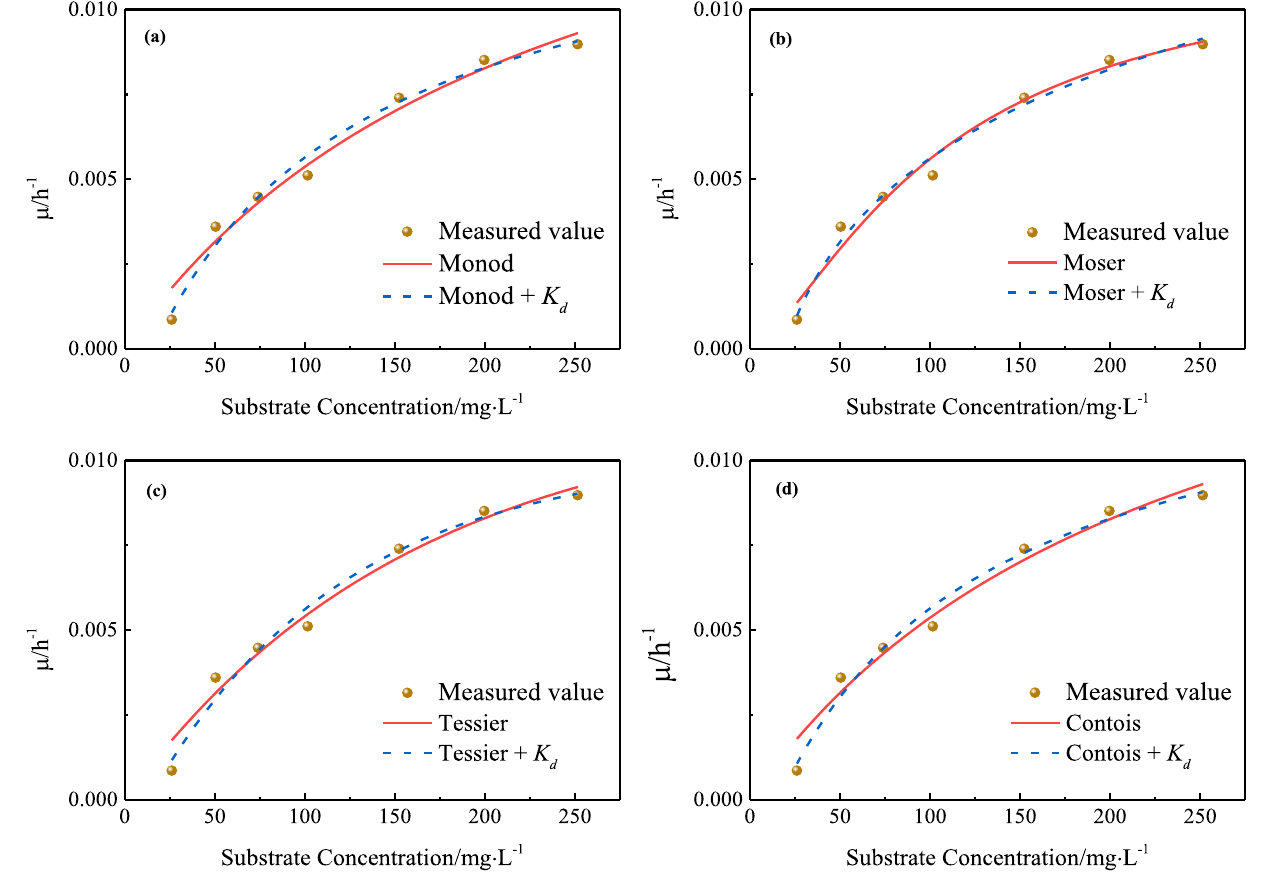
Figure 1. Nonlinear regression of microbial growth with and without cell decay using ( a ) Monod model, ( b ) Moser model, ( c ) Tessier model and ( d ) Contois